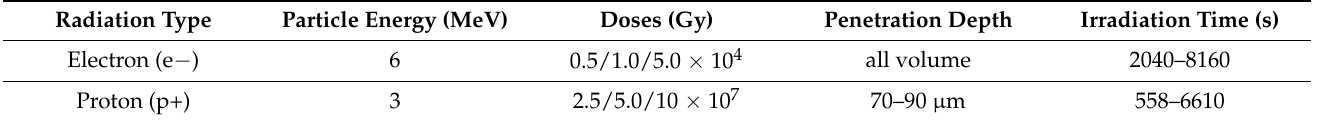
Table 3. The doses, penetration depths and irradiation times used for the radiation